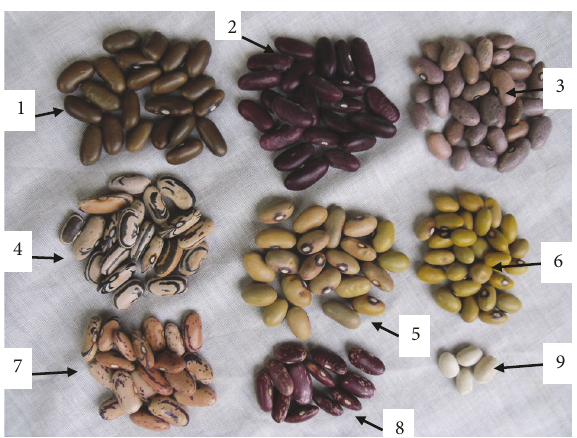
Figure 1: Beans types cultivated in the Southern Highlands Tanza- nia.